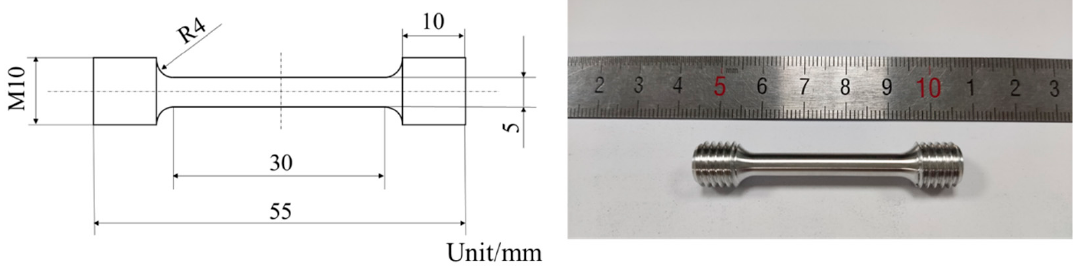
Figure 4. Schematic and physical diagram of the dog ‐ bone rod ‐ shaped standard tensile specimen.